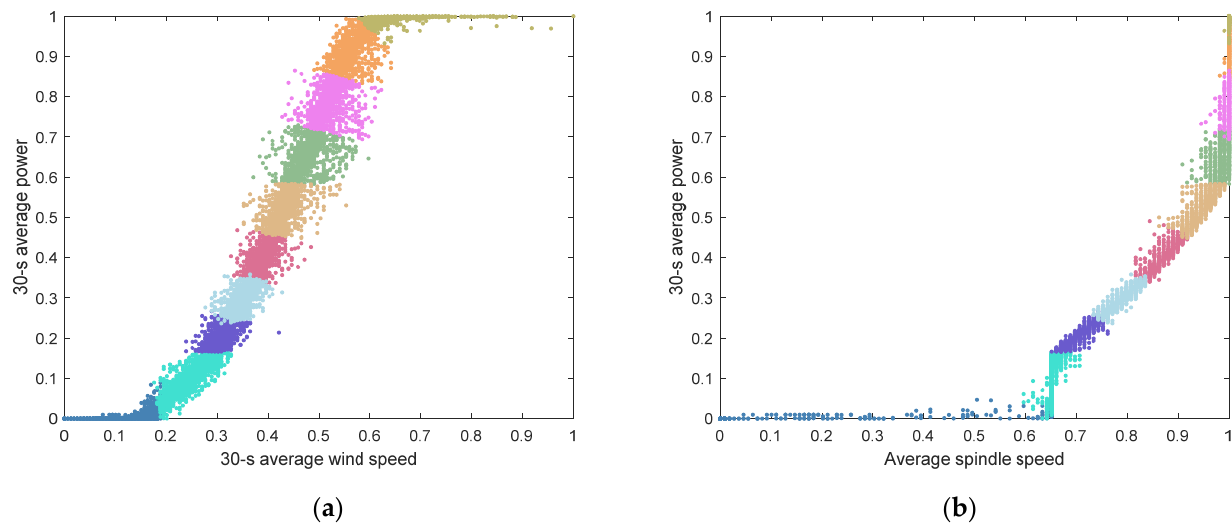
Figure 10. Results after subdivision of working conditions using the k -means clustering algorithm. ( a ) 30-s average wind speed vs. 30-s average power; ( b ) average spindle speed vs. 30-s average power.